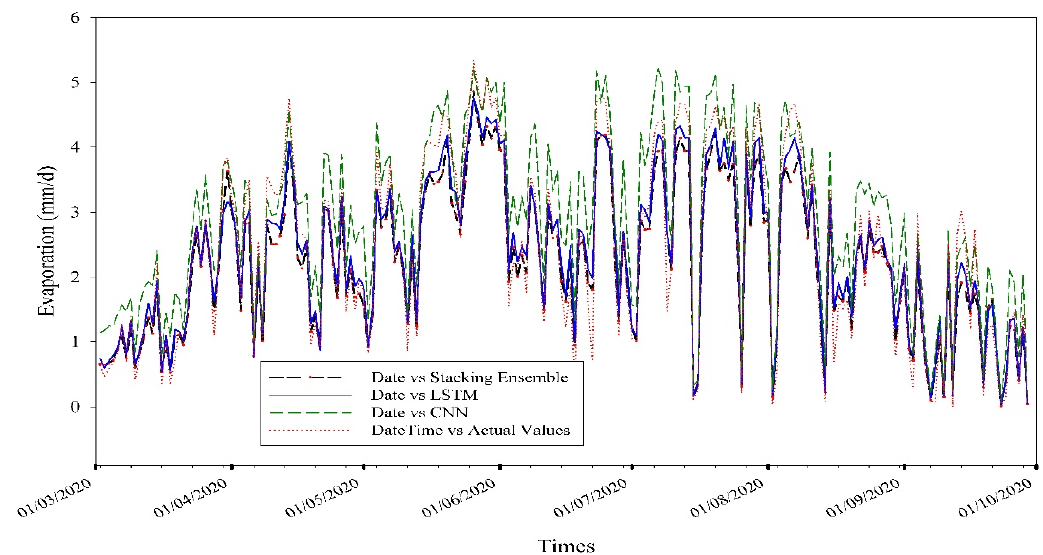
Figure 13. Graphical representation of ET prediction results by basic and ensemble models.